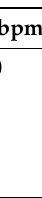
Table 1. Typical range of normal heartbeat for different age groups